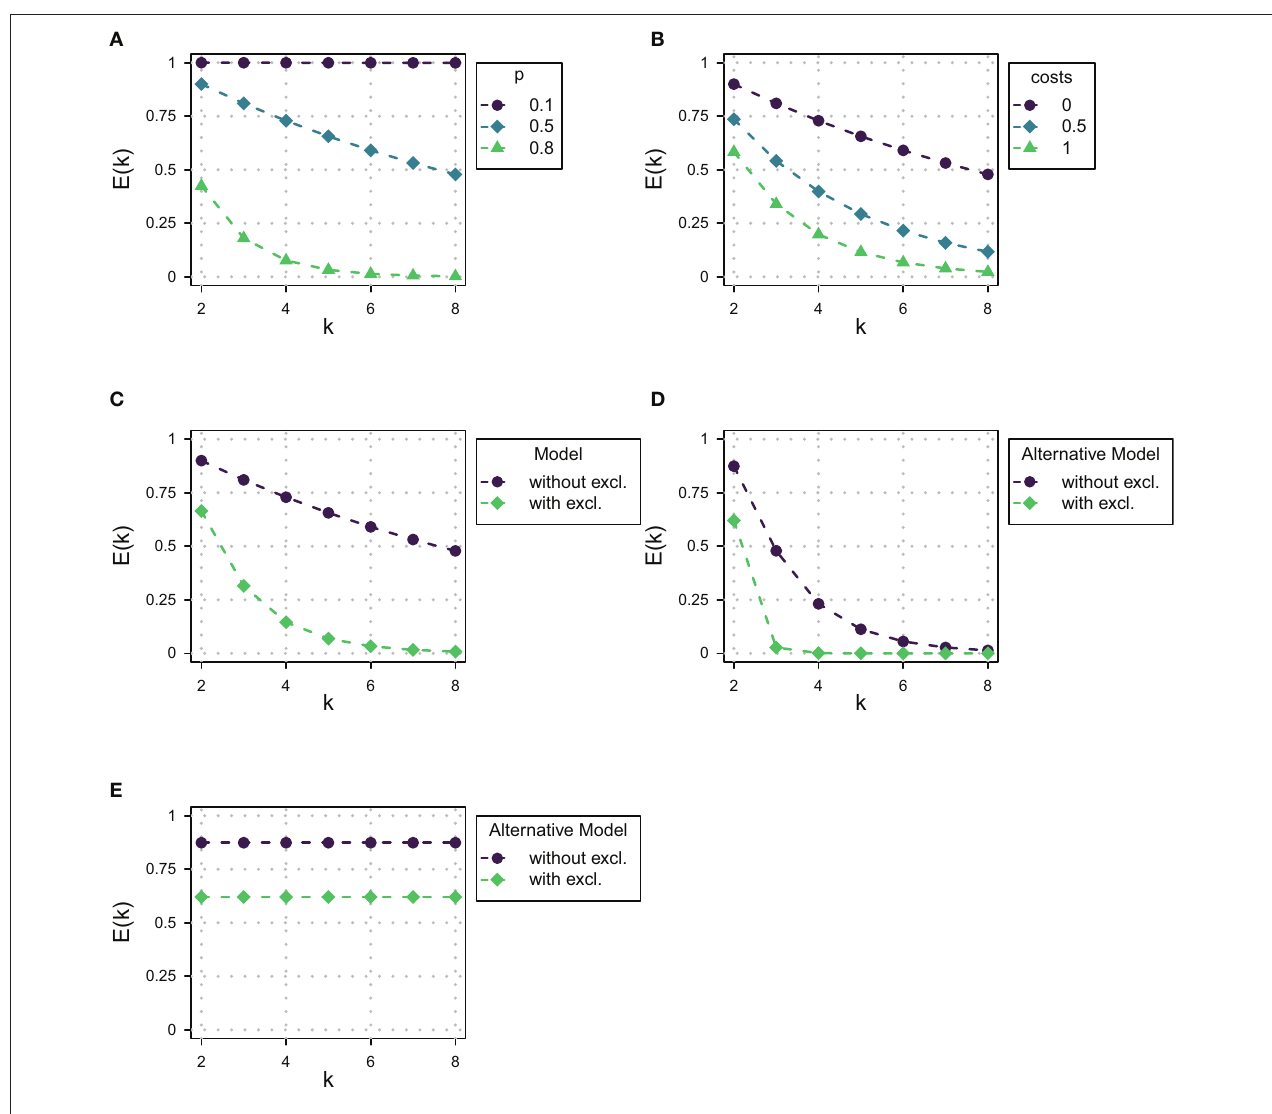
FIGURE 1 | RSA model predictions for the Exhaustivity E ( k ). (A) For p ∈ { 0.1,0.5,0.8 } and α = 3. (B) For cost per word ∈ { 0,0.5,1 } with α = 3 and p = 0.5. (C) With and without exclusive alternatives with α = 3 and p = 0.5. (D) With and without exclusive alternatives with α = 3 and p = 0.5 and with 2 alternatives and 2 states. (E) With and without exclusive alternatives with α = 3 and with 2 alternatives, 2 states and constant prior